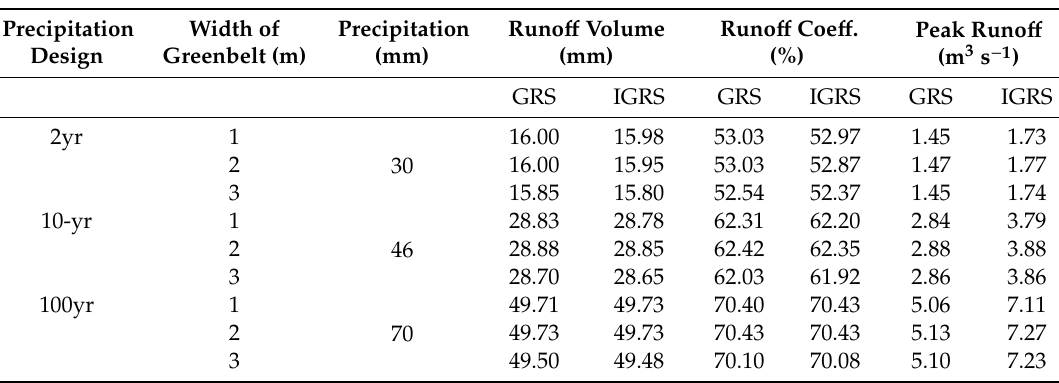
Table 9. Comparison of the surface runo ff between the GRS and IGRS in the single event simulation. Precipitation